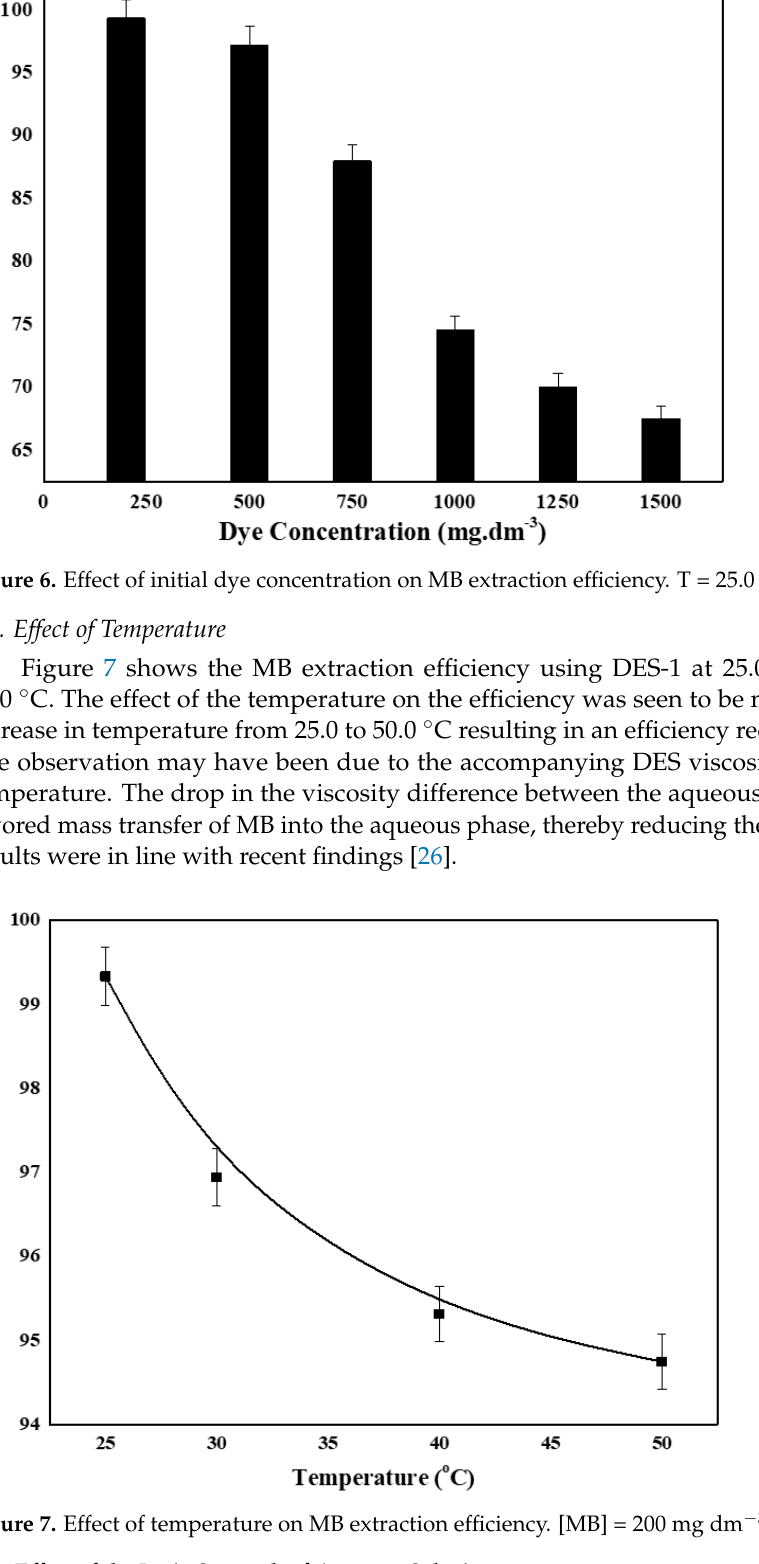
Figure 7. Effect of temperature on MB extraction efficiency. [MB] = 200 mg dm − 3 .